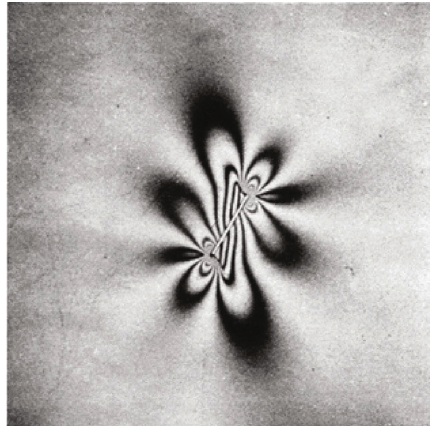
, (b) T , and (c) T . x y xy